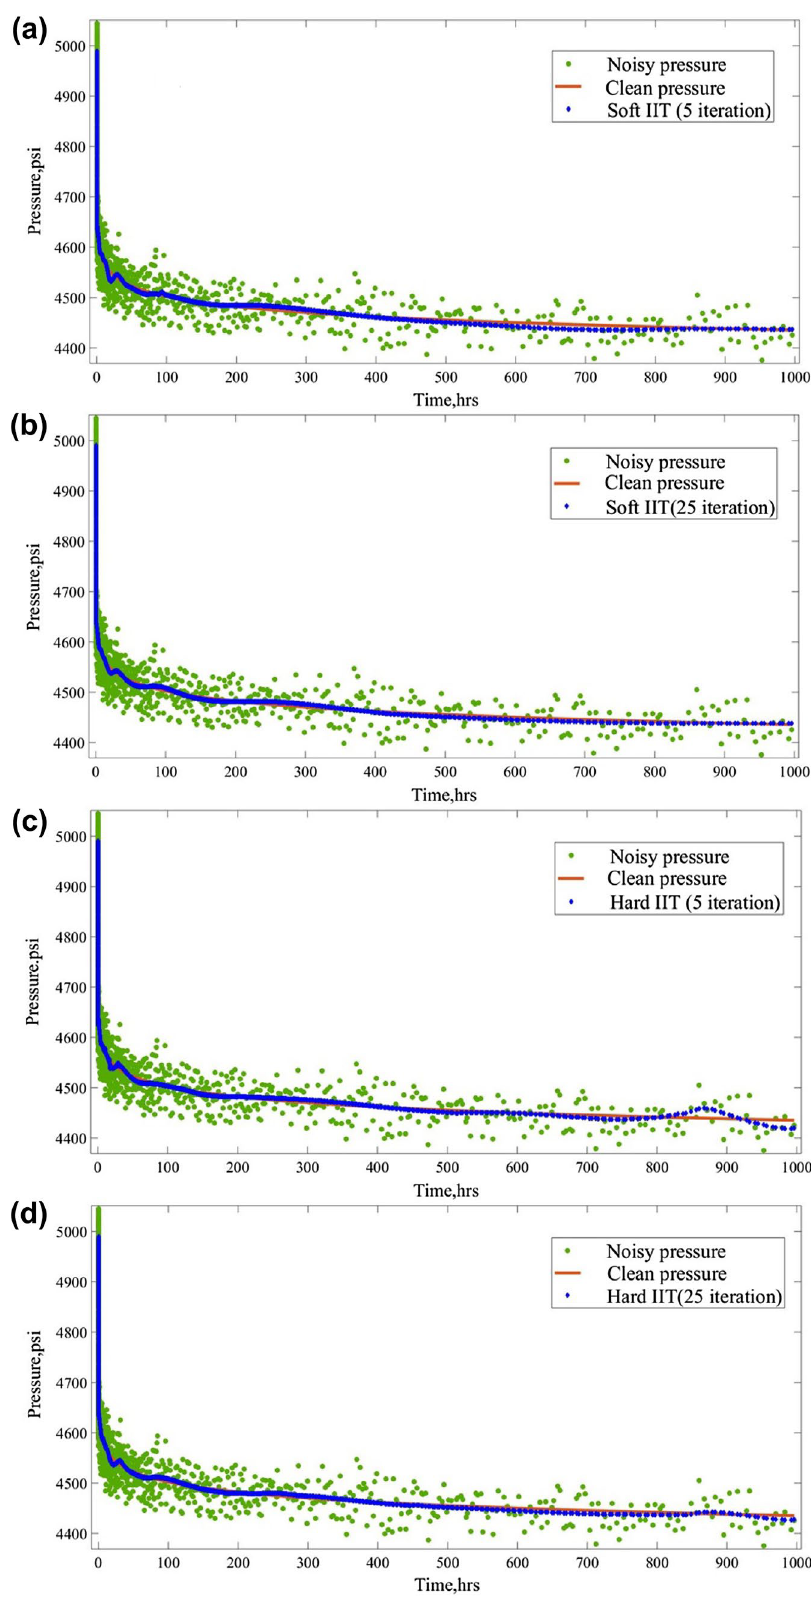
Fig. 10 Denoised pressure for a soft thresholding with 5 itera- tions, b soft thresholding with 25 iterations, c hard threshold- ing with 5 iterations, and d hard thresholding with 25